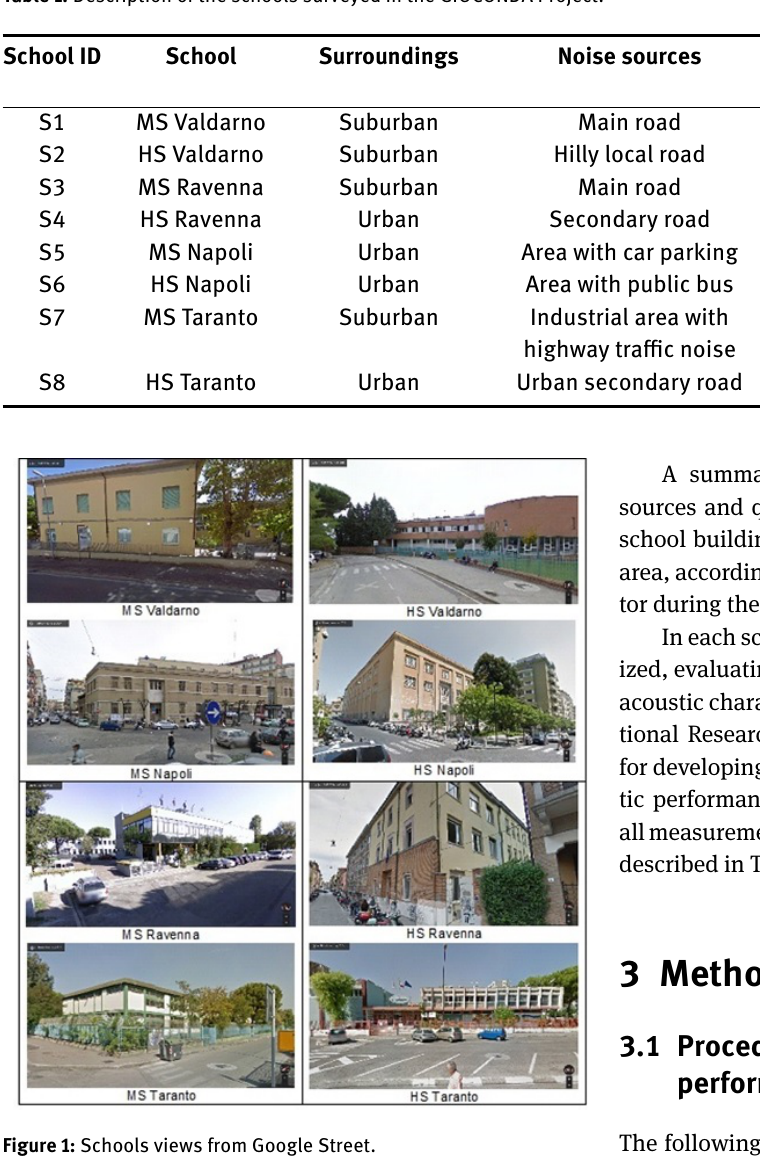
Table 1: Description of the schools surveyed in the GIOCONDA Project.